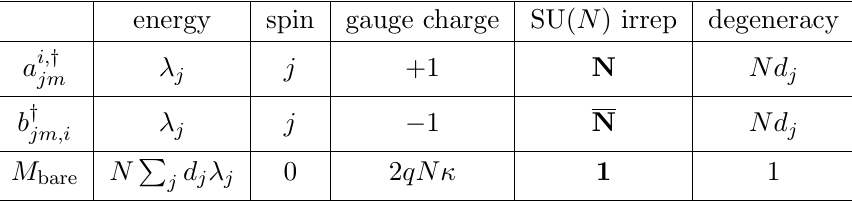
Table 3 . UV properties of modes and the bare monopole in scalar QED 3